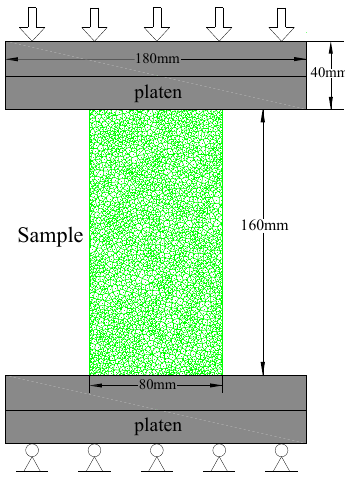
Figure 4. Numerical model of uniaxial compression test.